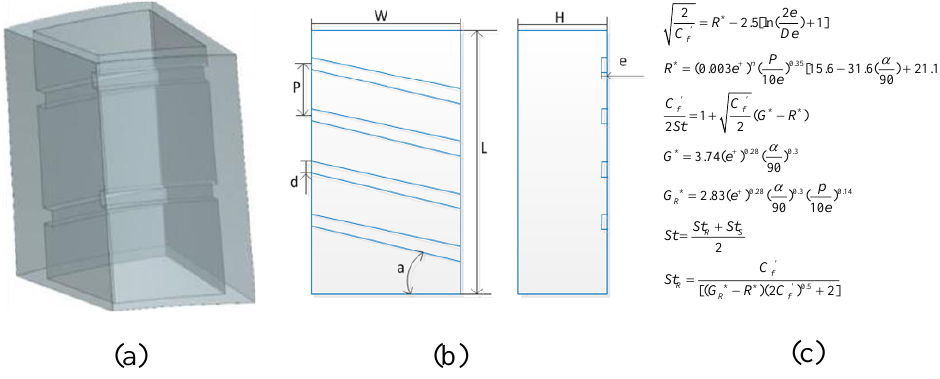
Figure 15. Schematic diagram of of main flowing unit calculation: ( a ) Main flowing unit model. ( b ) Geometric design parameters. ( c ) Extracted data formula [33].